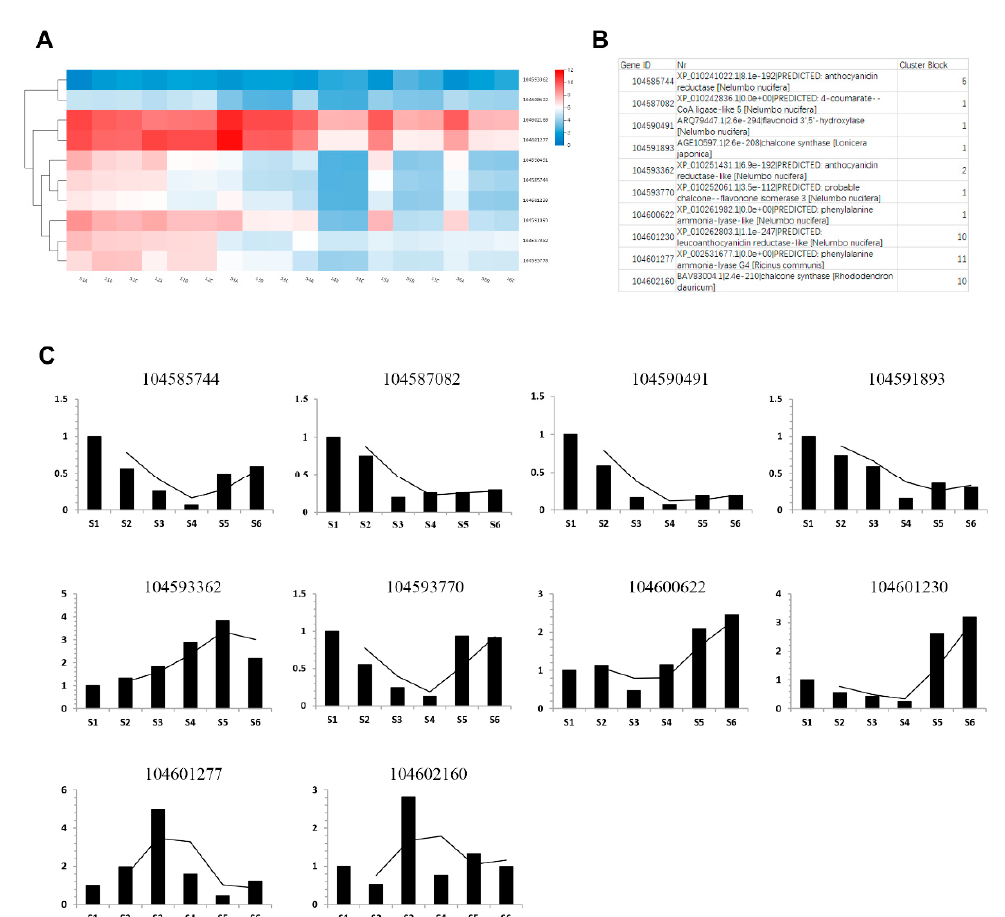
Figure 7. qRT-PCR confrmation of 10 candidate DEGs. ( A ) Heatmap of di ff erentially expressed genes selected from the six rhizome transcriptomes. Log-transformed expression values range from 0 to 12. Red and blue indicate di ff erent transcript levels. ( B ) Detailed information of candidate genes. ( C ) Relative gene expression levels determined by qRT-PCR. Relative gene expressions were normalized by comparison with the expression of lotus β -actin and analyzed using the 2 − ∆∆ C T method. The expression values were adjusted by setting the expression of S1 to 1 for each gene. qRT-qPCRs for each gene used three biological replicates, with three technical replicates per experiment; error bars indicate standard error (SE).